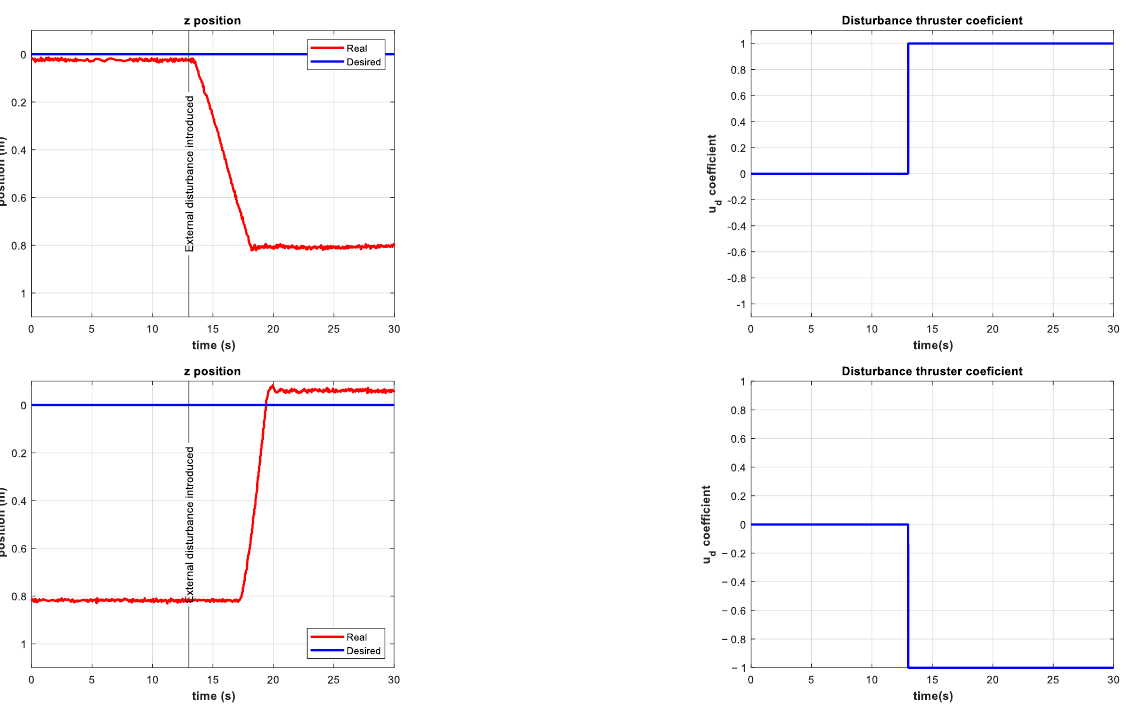
Figure 12. Results of the open-loop experiments. Depth of the vehicle ( upper left ) with an external disturbance of ~50 N ( upper right ) introduced at 𝑡 = 13 s . Depth of the vehicle ( lower left ) with an external disturbance of ~ − 40 N ( lower right ) introduced at 𝑡 = 13 s .